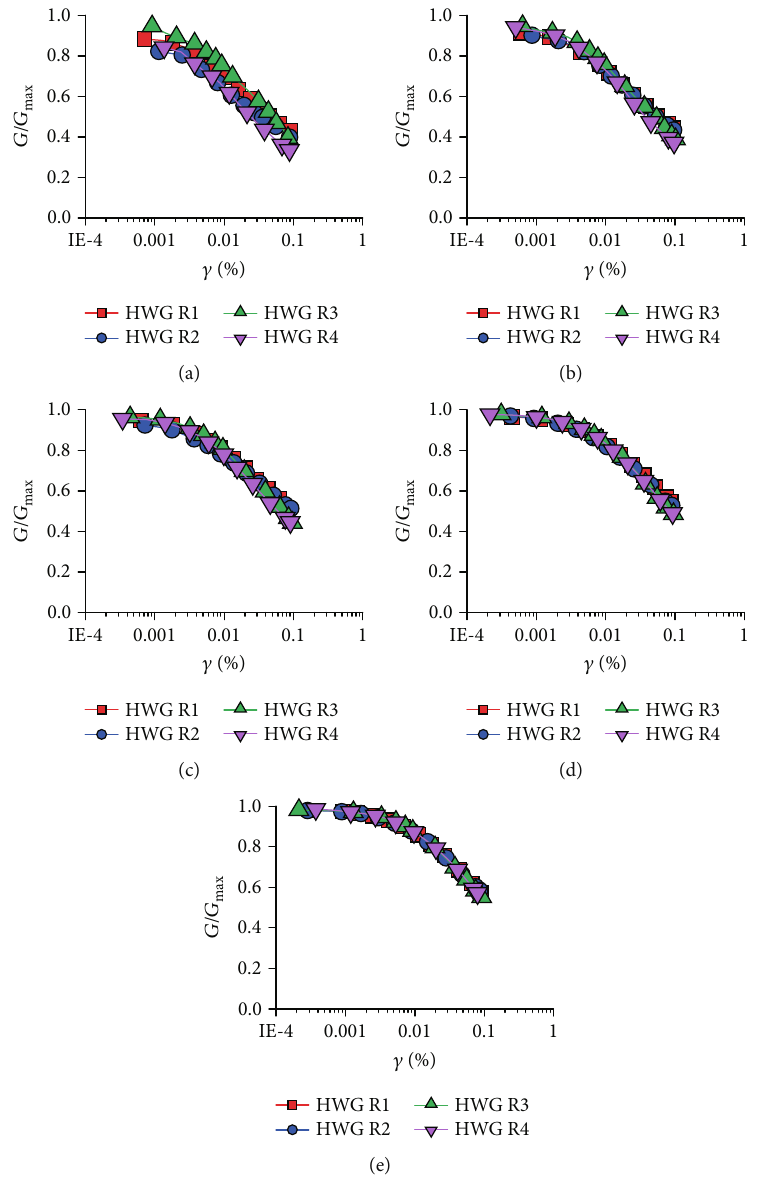
Þ − γ decay curves for remolded samples at varying initial dry densities at di ff erent e ff ective consolidation Figure 12: Normalized ð G / G max stresses: (a) 50kPa; (b) 100kPa; (c) 200 kPa; (d) 400kPa; and (e) 800kPa. (Data points